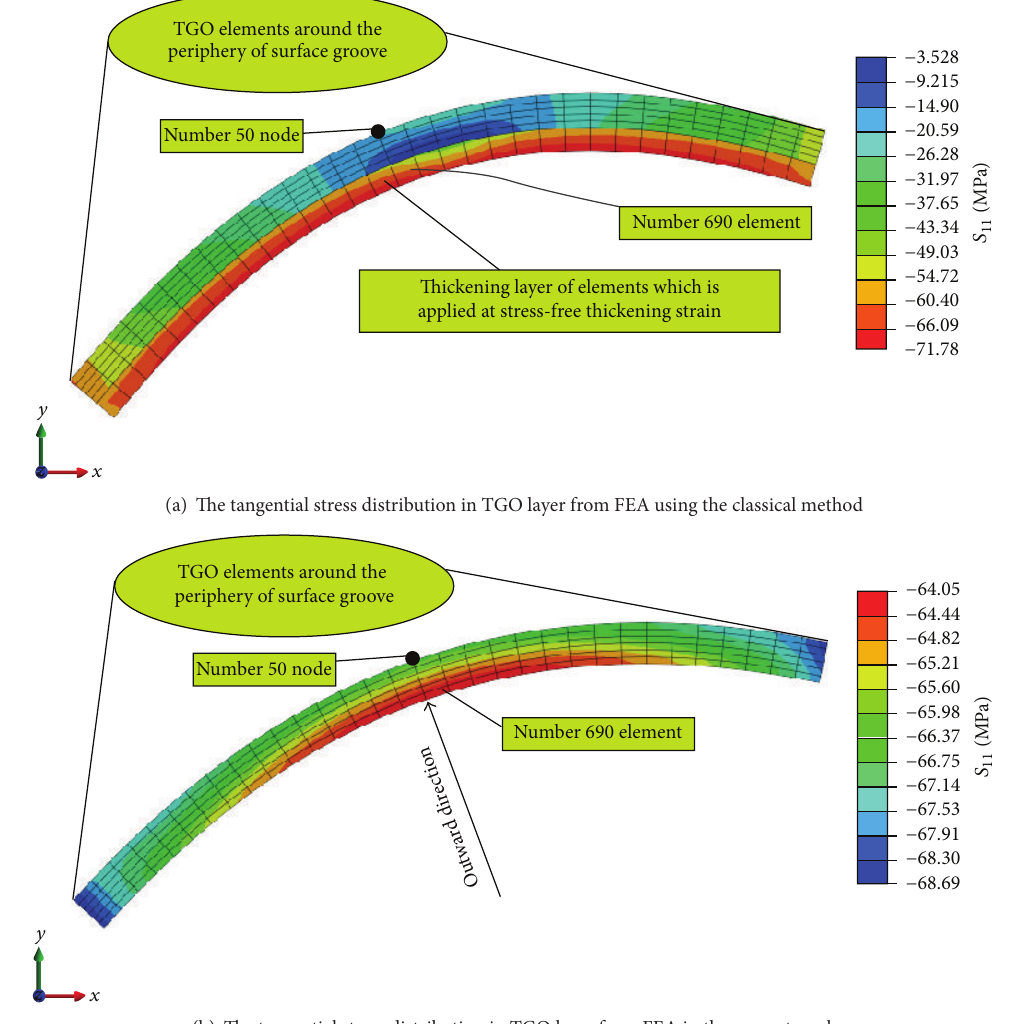
(b) The tangential stress distribution in TGO layer from FEA in the present work Figure 11: The tangential stress distribution in TGO layer around the periphery of the surface groove. (a) The result from the classical method and (b) the result from the present